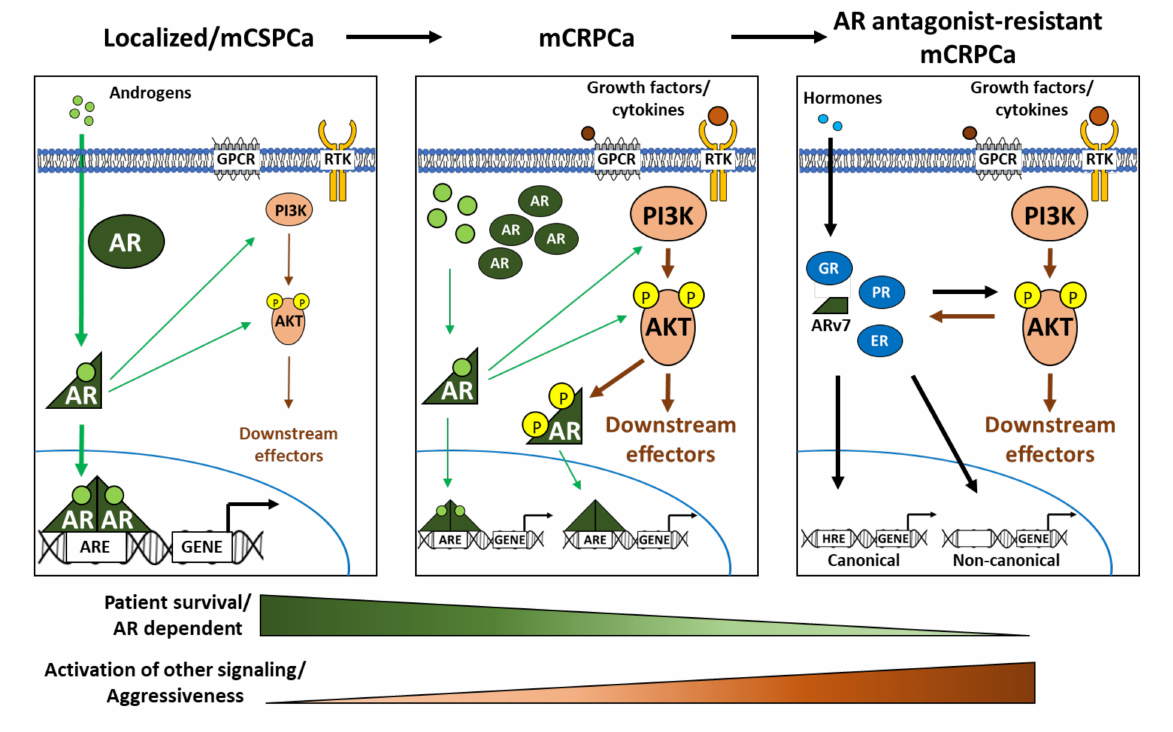
Figure 2. Transition from AR signaling-dependent to PI3K-AKT-mTOR pathway-dependent in PCa. PCa as a localized disease and at the early stage of metastatic disease is androgen- and castration-sensitive. The tumor at these stages strongly relies on systemic/circulating androgens for activating AR signaling to stimulate growth and progression (left panel). This makes it easy to suppress the tumor with therapeutic approaches that target androgen synthesis and AR signaling. However, after a certain period of time, the tumor will eventually develop a resistant stage called castration-resistance (middle panel). At this stage, ADT and the first generation of AR antagonists are not any more effective due to several hypothesized reasons, including intratumoral androgen synthesis, amplification of AR, activation of ligand-independent genomic AR signaling (e.g., via PI3K-AKT-mTOR), etc. These mechanisms suggest that the tumor at this stage still relies on AR signaling, although via adaptive responses, but could still be treated with second generation AR antagonists. Notably, bipolar androgen therapy (BAT) with cycling treatment of ADT and supraphysiological androgen levels seems to be also effective. Again, after a period of time, the tumor will become resistant to AR antagonist (right panel). Presumably, the therapeutic pressure by AR antagonists will selectively lead to the accumulation of PCa cells that no longer express AR or at least express mutated AR/AR splice variants (e.g., ARv7) lacking ligand binding domain. This makes the tumor insensitive to AR antagonists and BAT. Independent of AR, the tumor at this stage fully relies on hyperactivation of multiple cellular signaling cascades such as PI3K-AKT-mTOR and signaling of other nuclear hormone receptors (e.g., GR, PR, and ER). Along with more advance stages of the disease, an aggressiveness of the PCa is enhancing, whereas the survival of the PCa patient is reducing. AKT, protein kinase B; AR, androgen receptor; ARE, androgen response element; ARv7, androgen receptor splice variant 7; ER, estrogen receptor; GPCR, G-protein-coupled receptor; GR, glucocorticoid receptor; HRE,